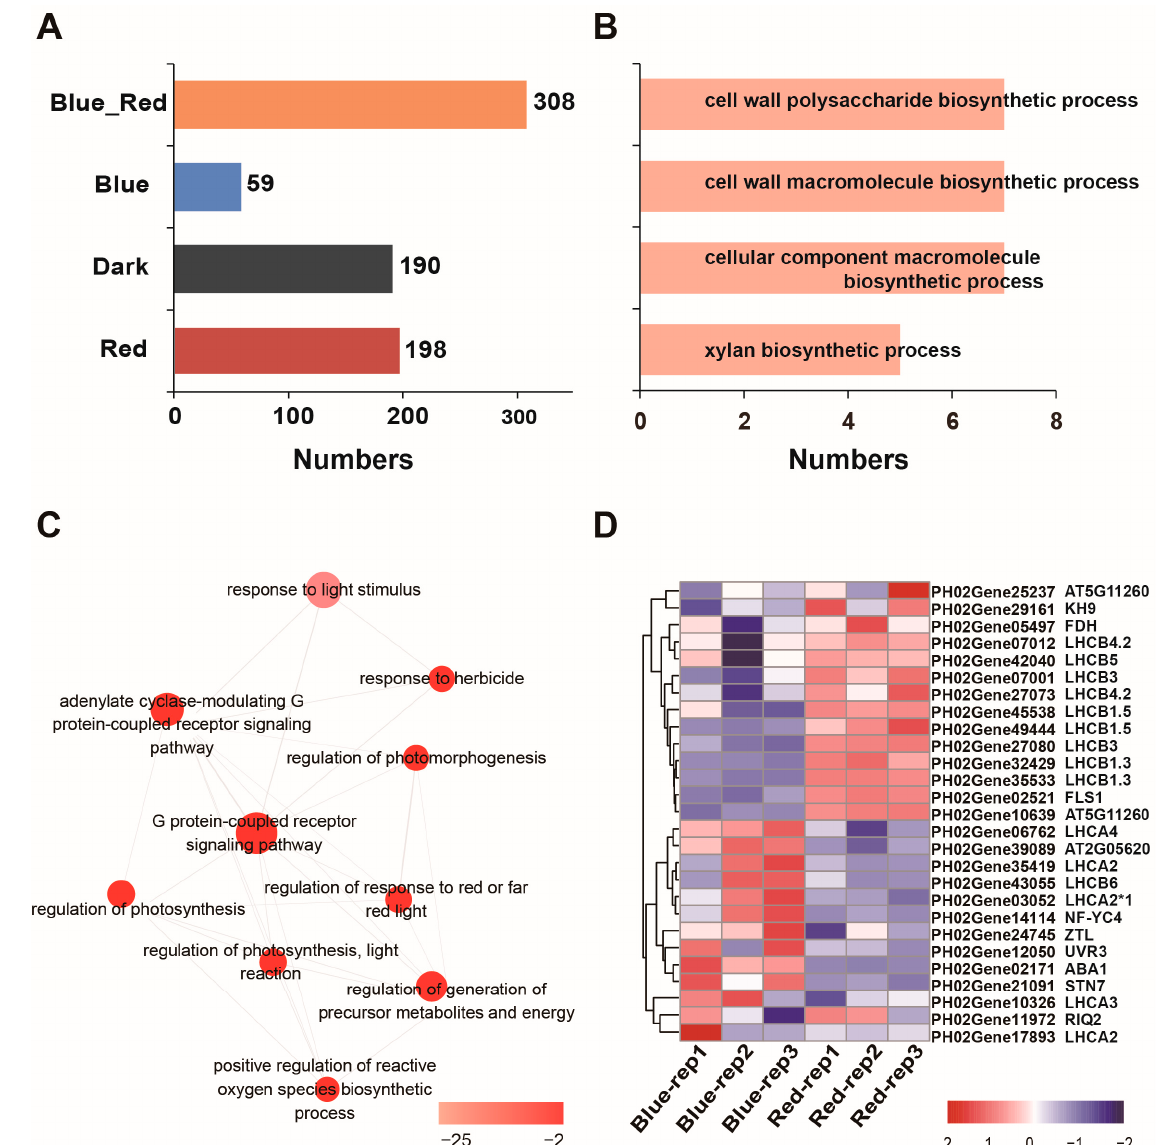
Figure 3. Gene ontology analyses of moso bamboo proteins under red light and blue light conditions. ( A ) The number of specific quantified proteins in moso bamboo under different light conditions. Blue_Red represents the group of proteins identified under red and blue light, but not in the dark. ( B ) Gene ontology (GO) enrichment analysis of the red light-specific quantified proteins. ( C ) Interactive graph of the gene ontology enrichment analysis of the proteins in Blue_Red in ( A ). The color of the bubble corresponds to the Log10 (FDR value of the GO term). The size of the bubble corresponds to the Log10 (number of annotations for the GO term ID in selected species in the EBI GOA database). ( D ) The heatmap showing the expression levels of specific quantified light stimulated proteins in Blue-Red.